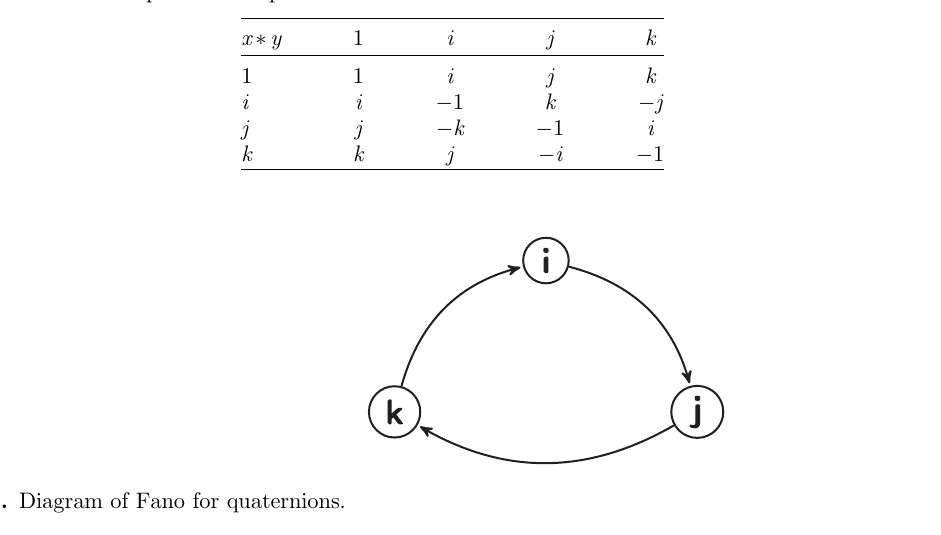
Table 1. Table of multiplication of quaternions.